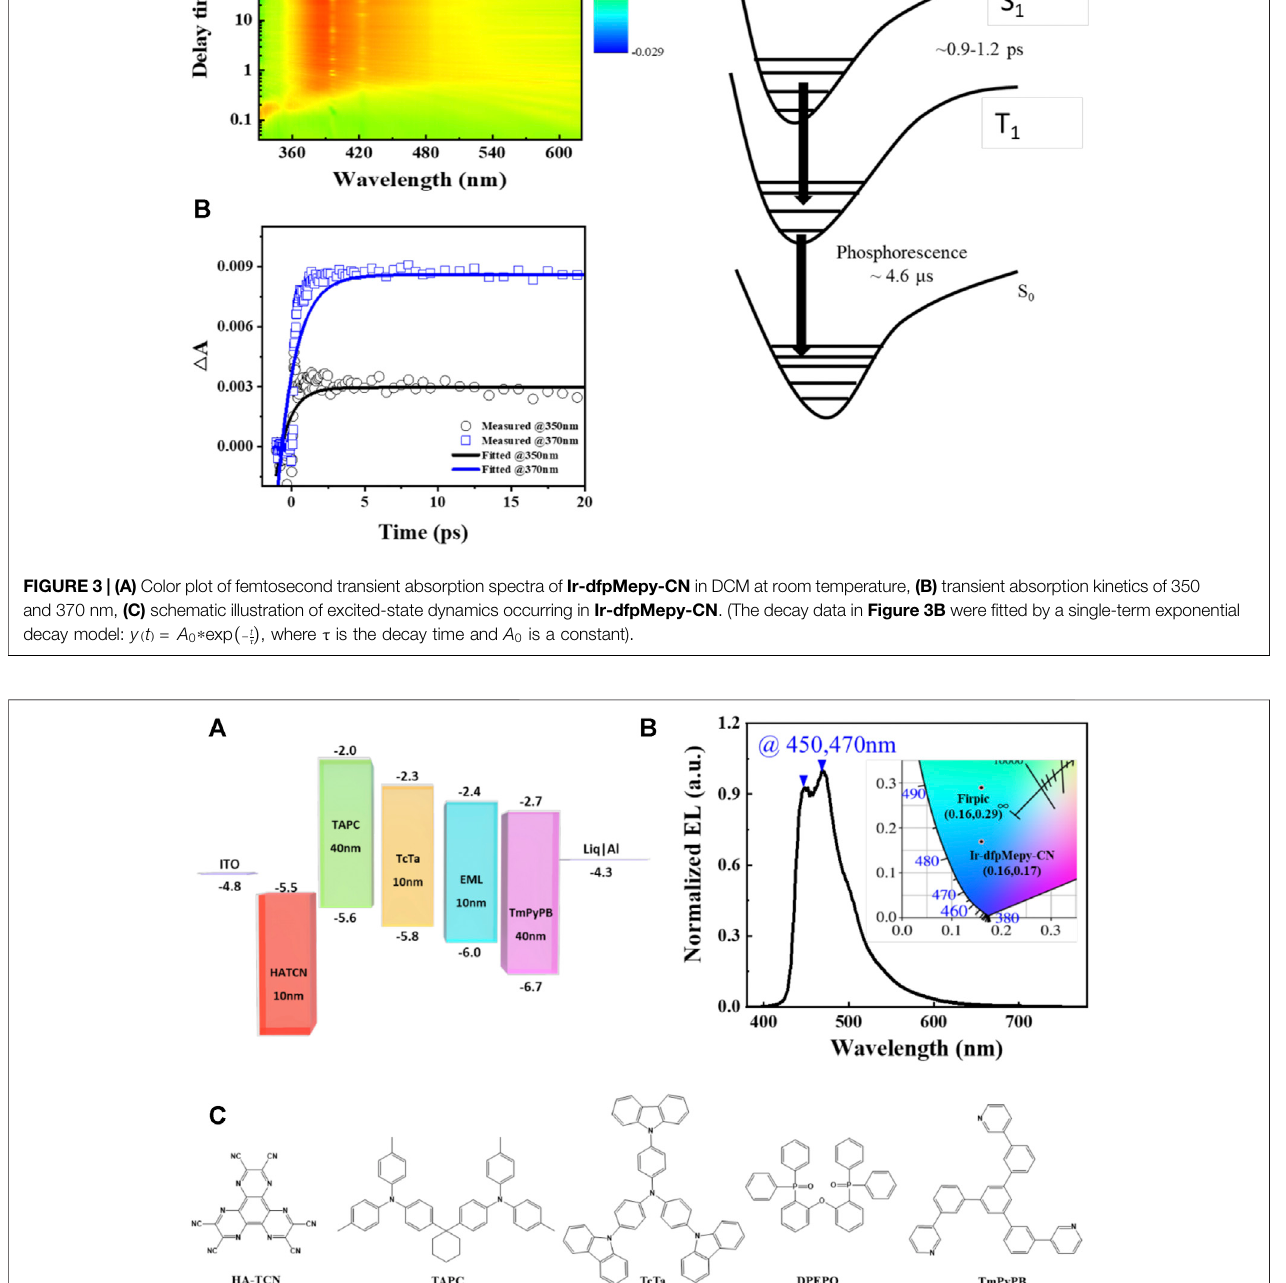
Supplementary Table S1 , the T 1 transition state is contributed by HOMO-3, HOMO-2, HOMO-1 and LUMO. Supplementary Figure S8 shows the frontier molecular orbitals calculated at T 1